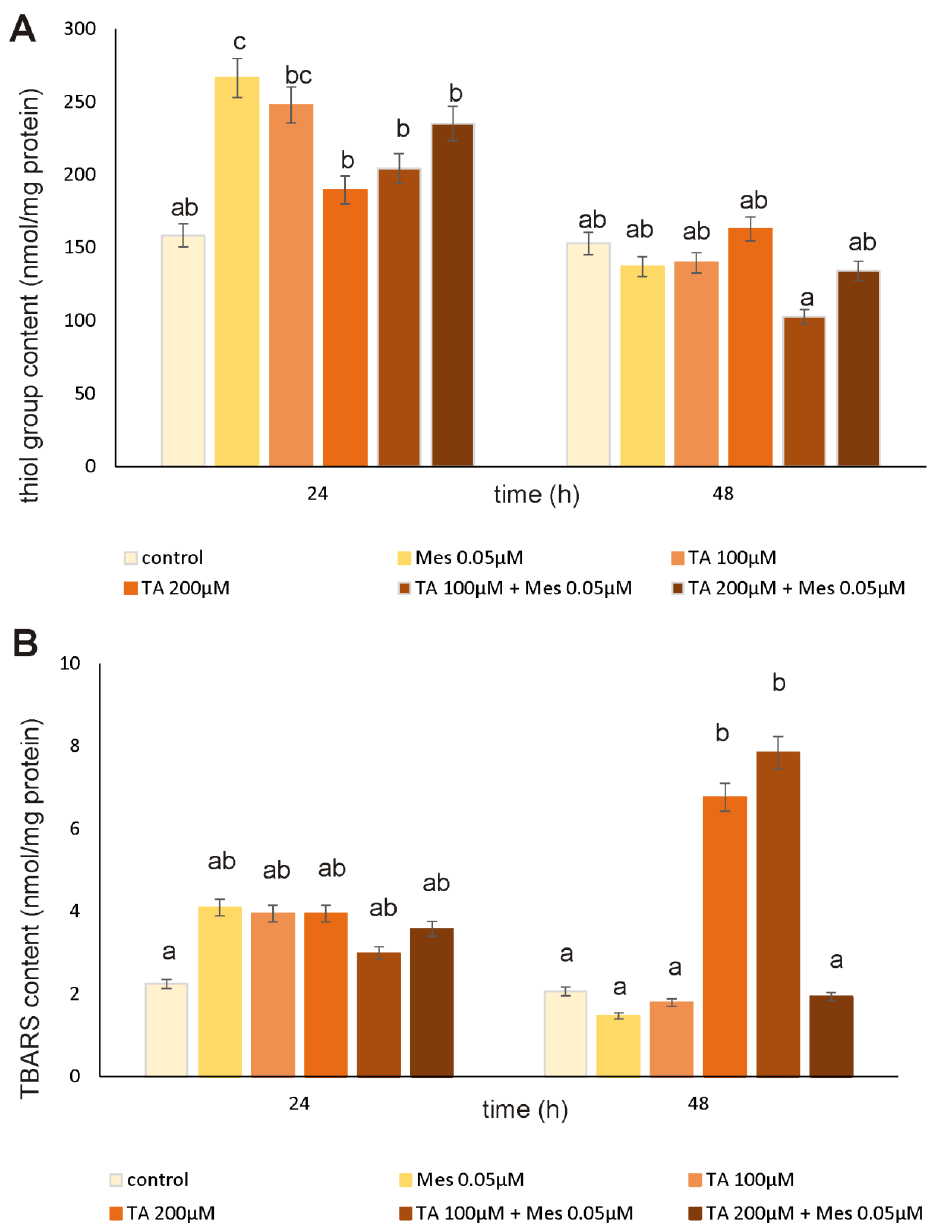
Figure 4. The influence of TA, Mes, and the mix of TA and Mes on SH group content ( A ) and TBARS content ( B ) in ZR-75-1 cells. The cells were cultured with 100 µ M of TA, 200 µ M of TA, 0.05 µ M of Mes, mix of 100 µ M TA + 0.05 µ M Mes, and 200 µ M TA + 0.05 µ M Mes for 24 h and 48 h. Mean values from three independent experiments ± SD are shown. Di ff erent letters indicate statistical di ff erences ( p ≤ 0.05) between each treatment estimated by Tukey’s test.